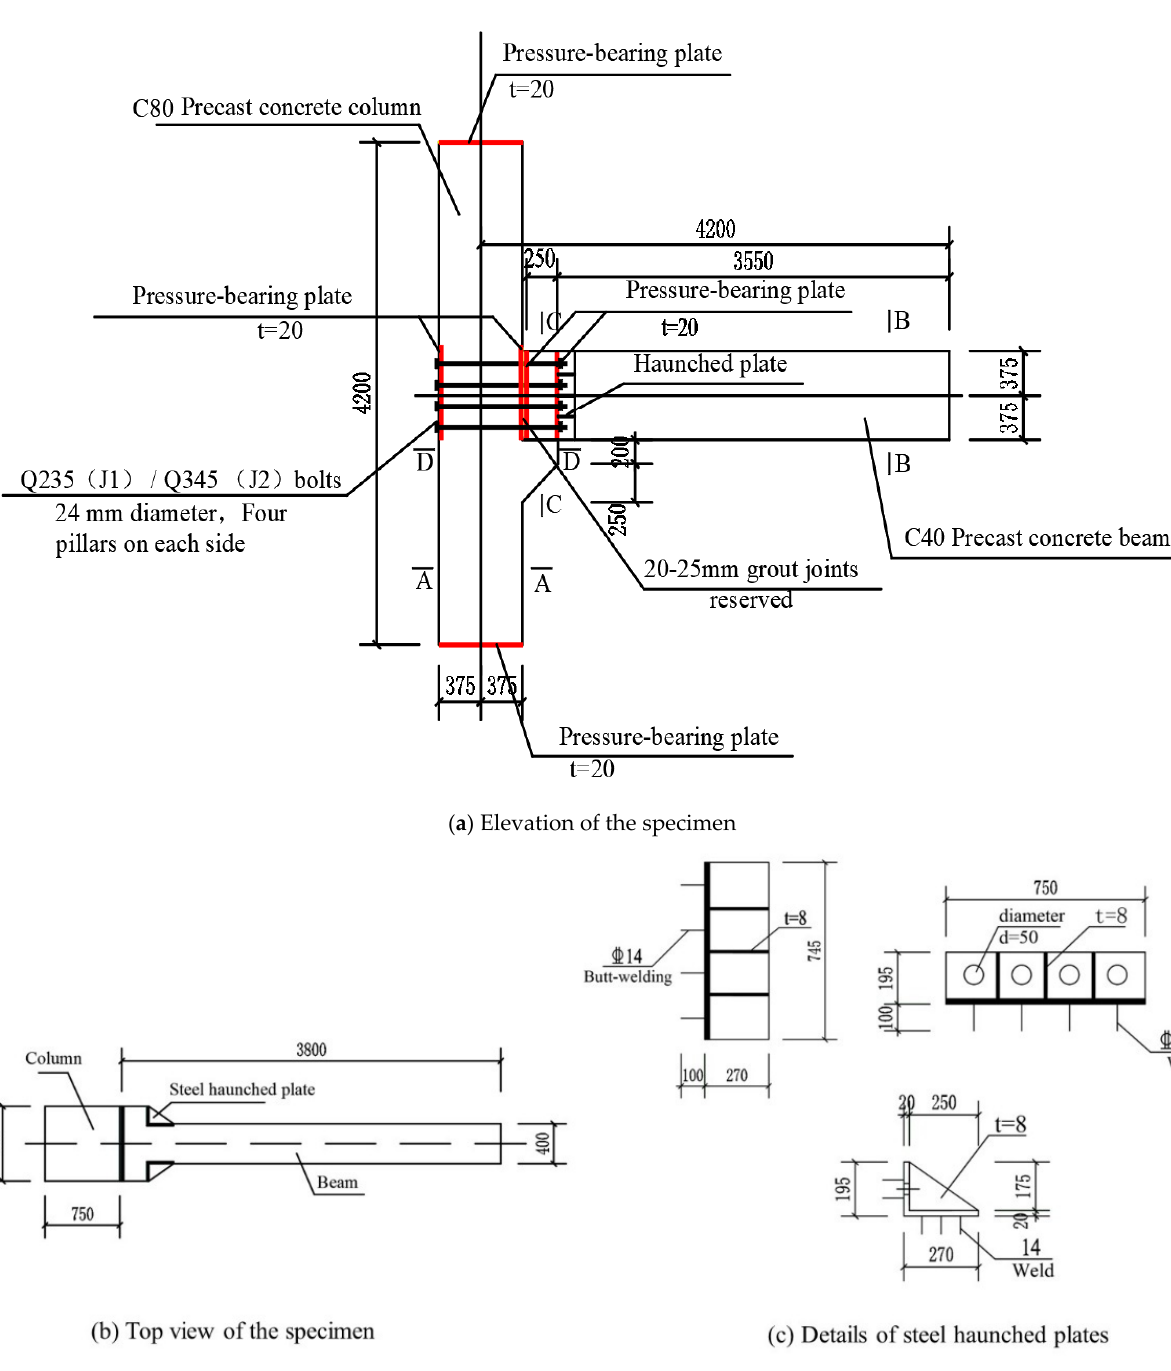
Figure 1. Design of the specimen. Precautions for making test pieces: firstly, the bolt holes are produced in strict accor- dance with the bolt holes corresponding to the respective required connection positions, with precise dimensions (error in millimeters), otherwise it will affect the smooth butt joint of bolt connectors during splicing; secondly, pay attention to the protection of steel strain gauges. Before steel binding, the position of strain gauges must be predicted to avoid collision with formwork and vibrators; finally, the precast beams and precast columns are assembled by bolt splicing, and the splicing is calibrated with a laser